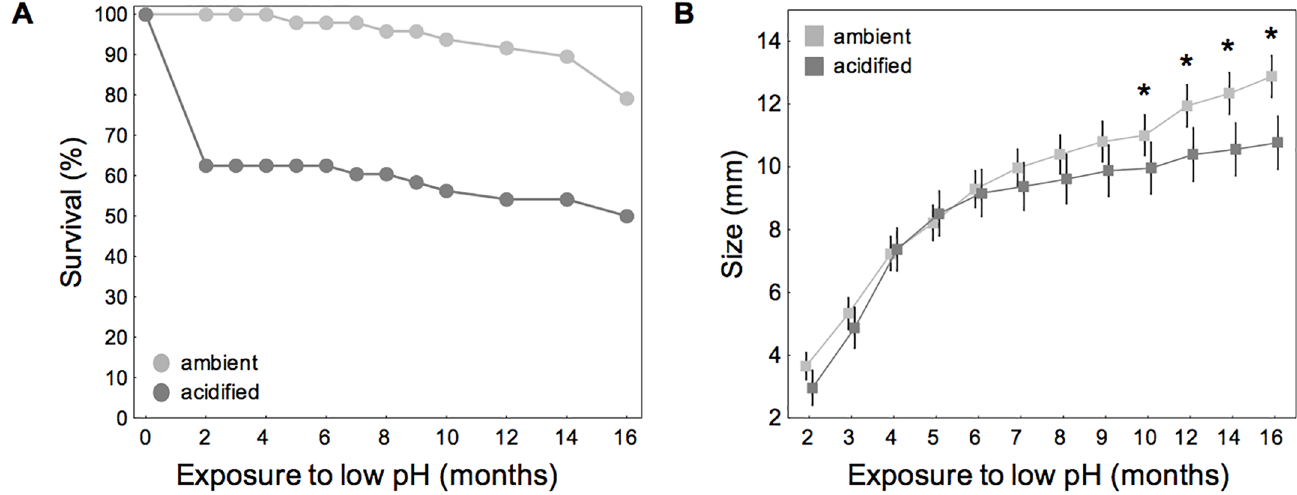
Fig 1. Survival (A) and growth (B; size over time) of laboratory-bred single barnacles. B . improvisus was incubated at two different pH treatments ( Δ of 0.6 pH units) for 16 months. Deviations denote 95% CIs from the mean. Treatment differences following posthoc comparisons are indicated by (cid:3) p < 0.05, (cid:3)(cid:3) p < 0.01, (cid:3)(cid:3)(cid:3) p < 0.001 (survival: N = 48; final size: N ambient = 38, N acidified = 23).